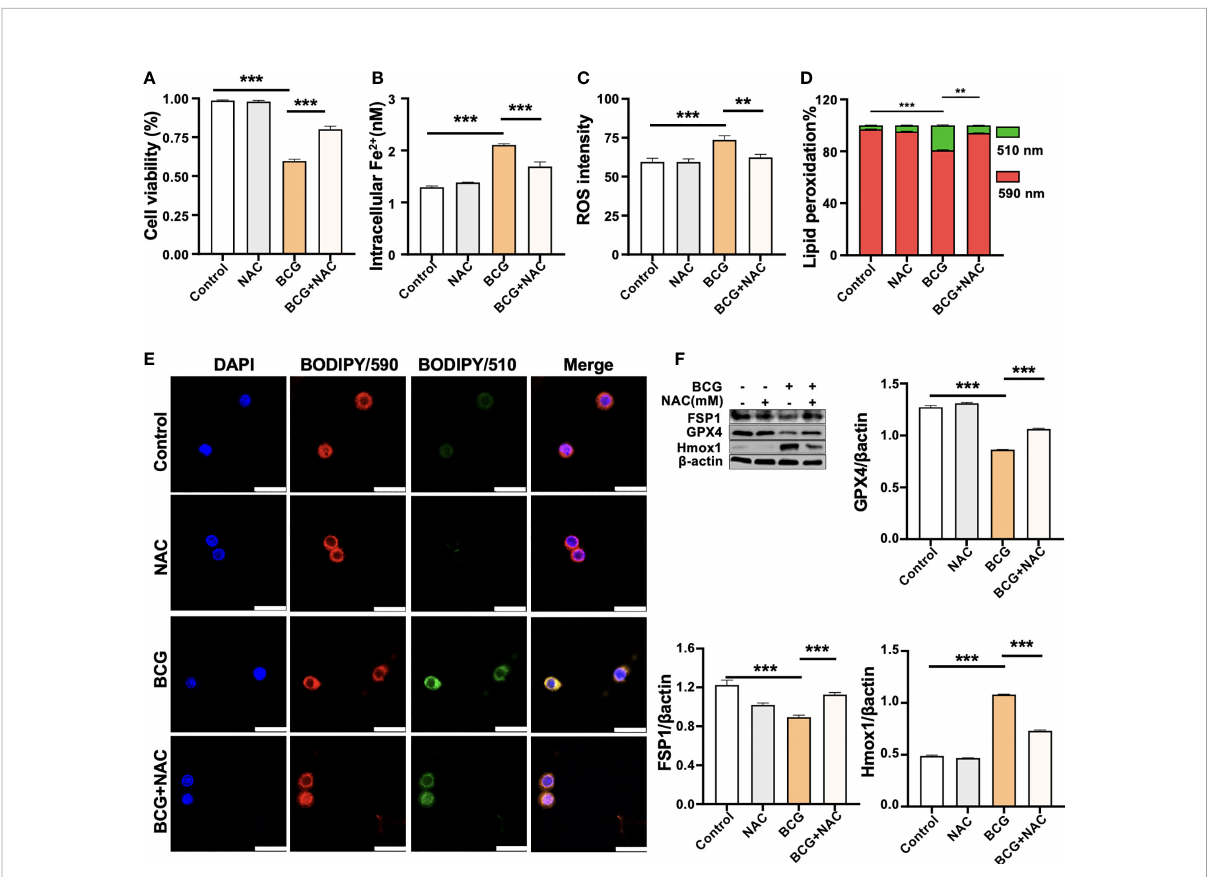
FIGURE 5 ROS scavenger NAC reduces BCG-induced macrophage ferroptosis. RAW264.7 macrophages were preincubated in medium containing 2.0 mM NAC for 1 h prior to being infected with BCG at an MOI of 5 for 24 h, before they were harvested for analysis. (A – D) The viability (A) , intracellular Fe 2+ (B) , intracellular ROS (C) , and lipid peroxidation (D) of RAW264.7 macrophages treated with the indicated conditions, as determined by Trypan Blue assay, iron ion probes, fl ow cytometry, and BODIPY 581/591 C11 assays, respectively. (E) Representative fl uorescence images of BODIPY 581/591 C11-labeled lipoxidation of polyunsaturated fatty acids in RAW264.7 macrophages of the indicated conditions showed the reduction of BCG-induced lipoxidation in cells pretreated with NAC. Cell nuclei were counterstained with DAPI. (F) Representative blots and semi-quantitative analysis of Gpx4, Fsp1, and HO-1 proteins of RAW264.7 cells treated with the indicated conditions. The NAC pretreatment increased Gpx4 and Fsp1 expression, but decreased Hmox1 protein in BCG-infected cells. Data obtained from three independent experiments were processed using GraphPad Prism 8.0.1 software and ImageJ 1.52.a. All values are presented as mean ± SD (** p < 0.01, and *** p < 0.001; n =